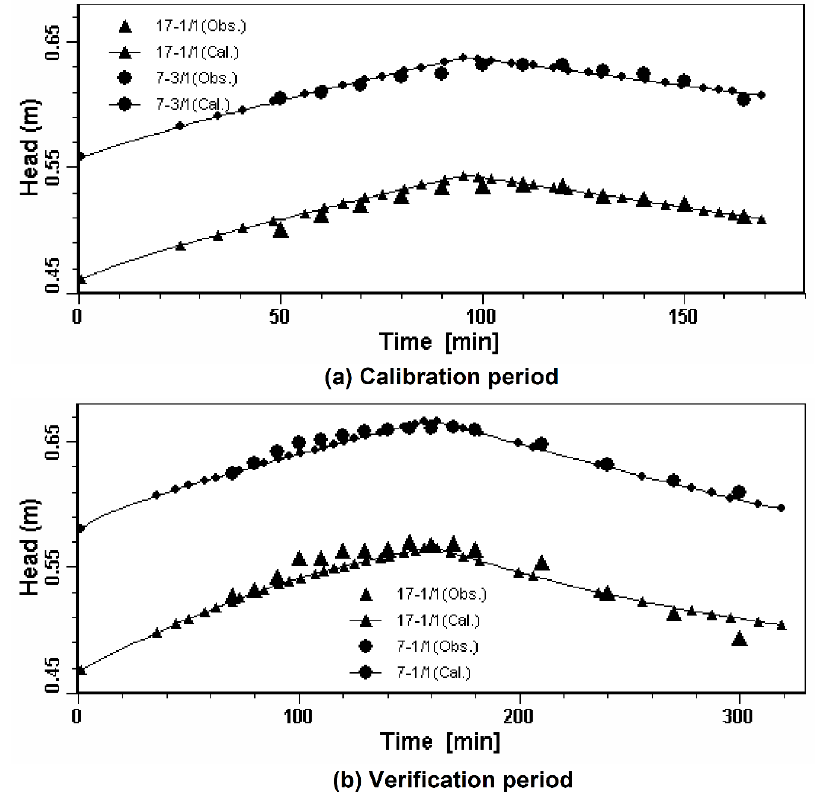
Figure 4. Time-series graphs of the calculated vs. observed values during the calibration period ( a ) and the verification period ( b ). The observed heads are shown as larger dots and triangles. The calculated heads are shown as smaller dots and triangles with lines.